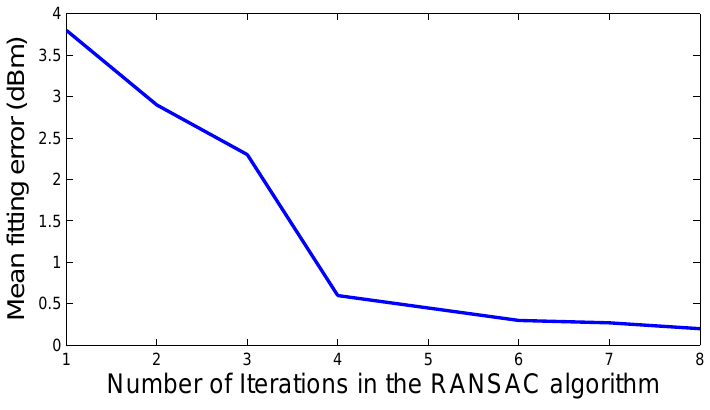
Figure 4. Mean model fitting error assuming different numbers of RANSAC